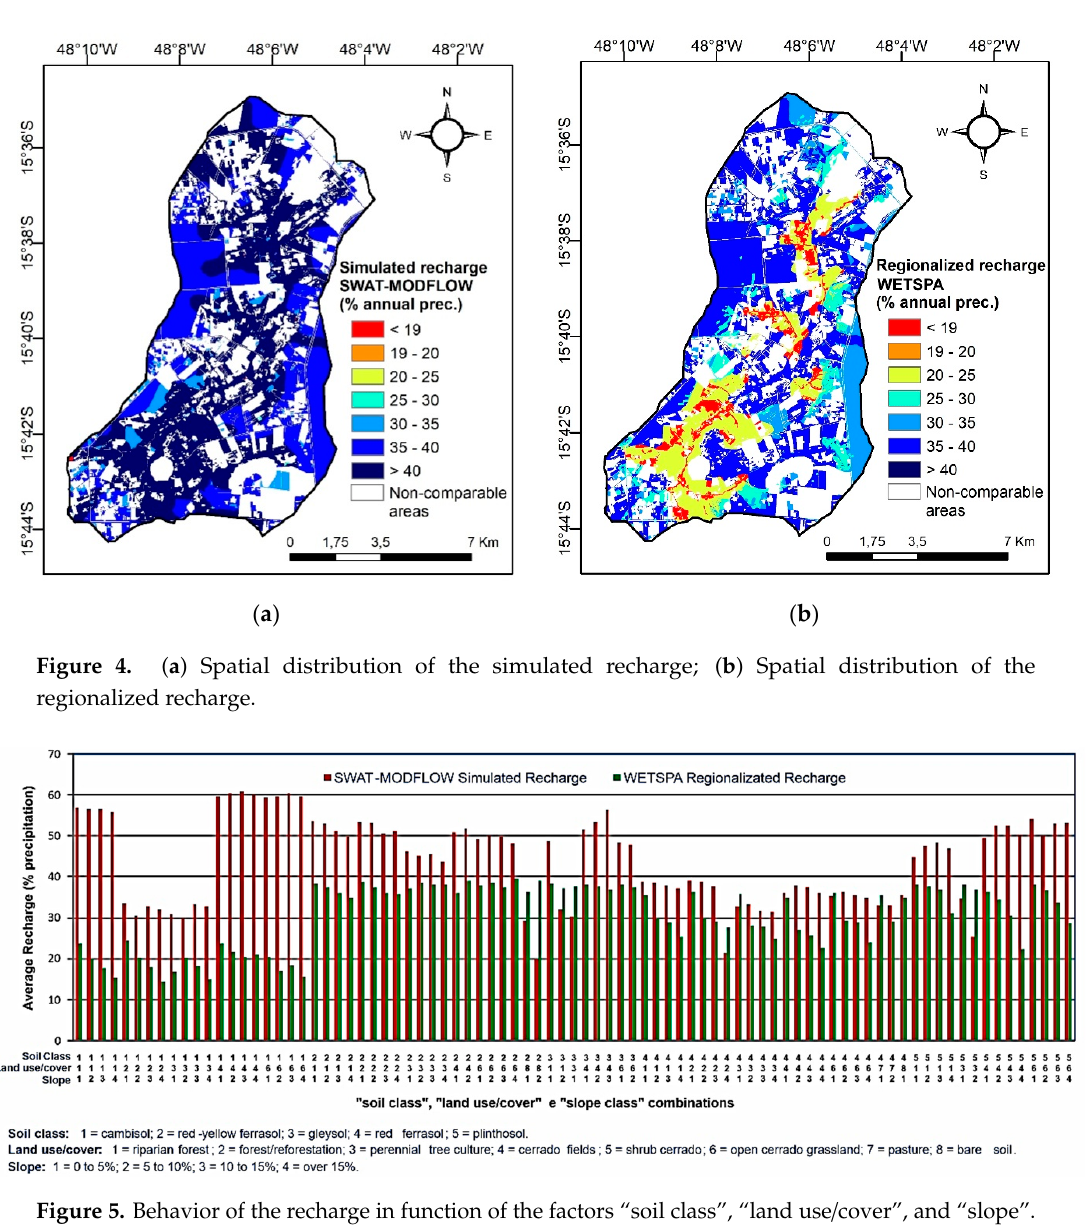
Figure 5. Behavior of the recharge in function of the factors “soil class”, “land use/cover”, and “slope”.